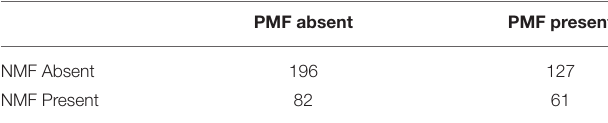
TABLE 2 | Count of trials with and without positive and negative behavioral